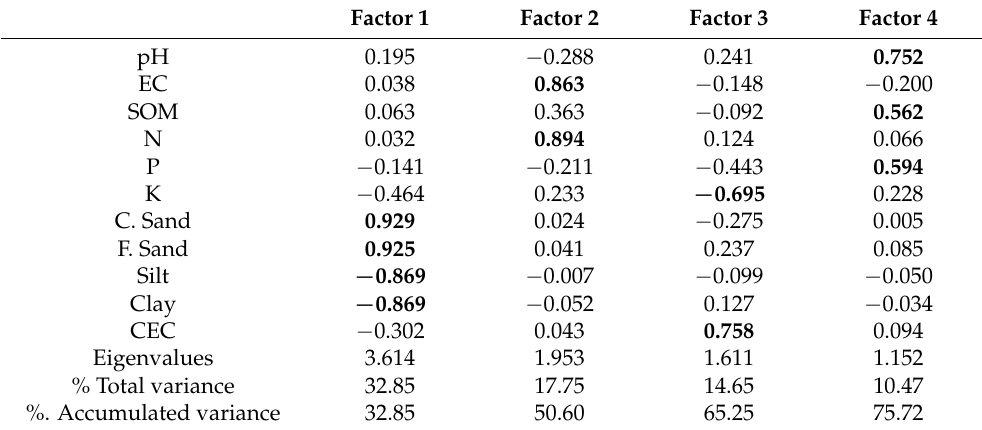
Table 9. Factor loadings, eigenvalues, percentage of total variance, and accumulated variance, in a four-factor model of 11 observed soil variables in the 20–40 cm